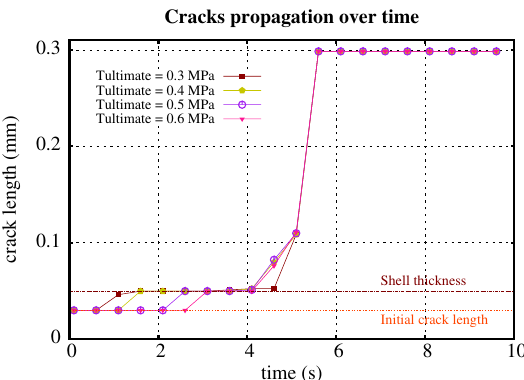
Figure 2. Crack propagation profile over time with different stiffnesses of the shell.